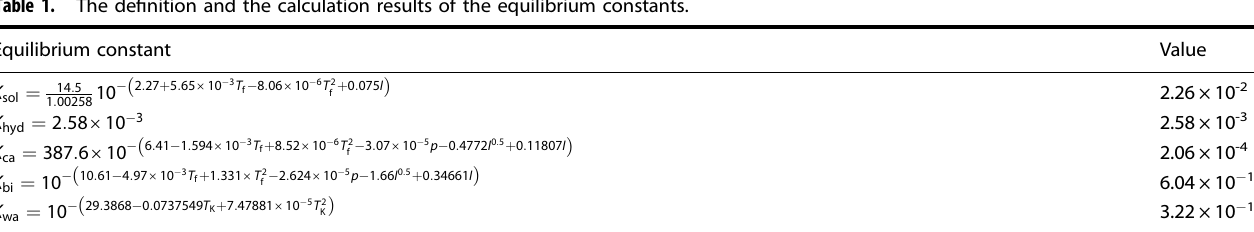
Fig. 8 The calculated corrosion depth and the measurement error. a The corrosion depth map calculated from the i ai,j . b The measurement error between the calculated value and the real corrosion depth measured by 3D pro fi les. Table 1. The de fi nition and the calculation results of the equilibrium